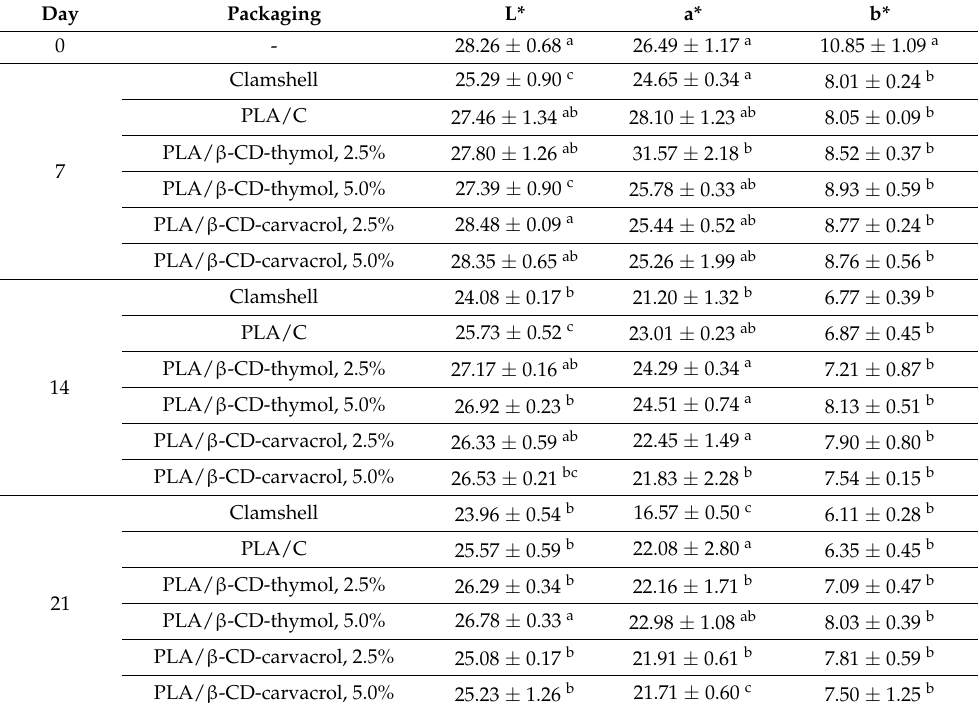
* Values are reported as average ± standard deviation of triplicate determinations. Values in the same column with different letters are significantly different statistically ( p < 0.05). Table 2. Changes in color parameters (L*, a*, b*) of raspberries under different packaging at 0, 7, 14, and 21 days of storage at 4 ◦